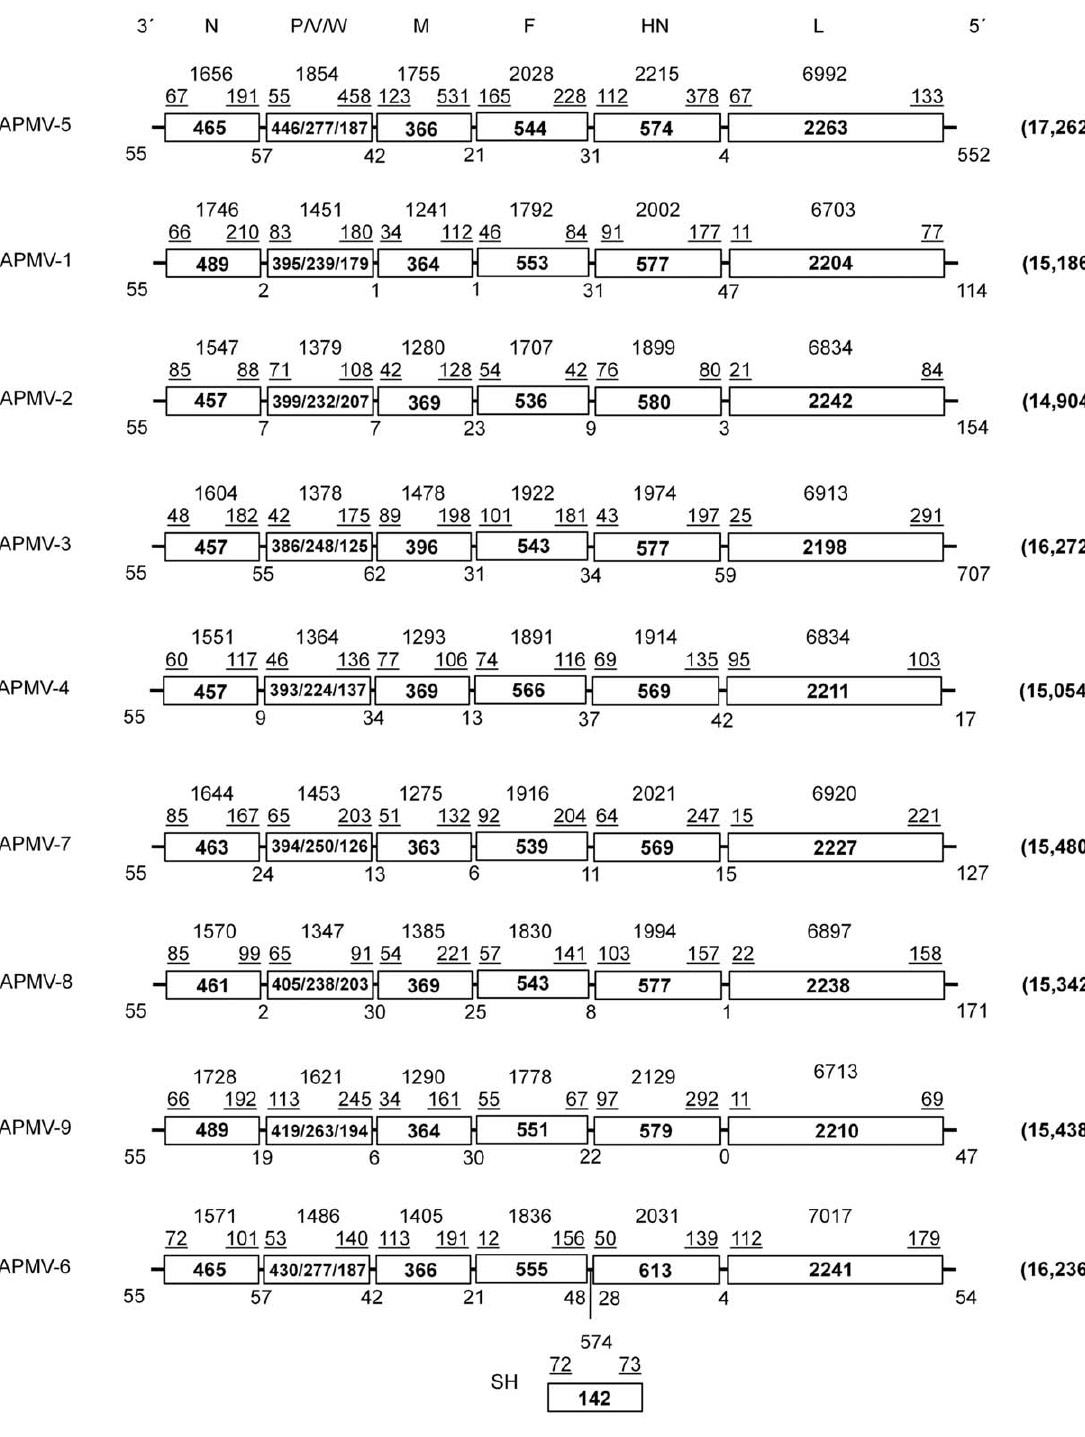
Figure 1. Gene map of APMV-5 and comparison with prototype strains for the other eight APMV serotypes (maps not to scale). Individual genes are indicated by rectangles, with the gene names given at the top of the Figure. The amino acid length(s) of the encoded protein(s) is shown in each box. The nt length of the gene is shown over each box. The lengths of the non-translated upstream and downstream regions (which also are represented in the total gene length) are indicated by underlined values immediately over each box. The nt lengths of the non-coding leader, intergenic, and trailer regions are shown under each map, and the total genome nt length is shown in parentheses to the right. The SH gene is present in APMV-6 but not in the other APMVs. Upstream UTRs include the GS sequence and the downstream UTRs include the GE sequence. The prototypes strains used here and in the other Figures and Tables are as follows: APMV-5, APMV-5/budgerigar/Kunitachi/74 (present study); APMV-1, Newcastle disease virus (strain LaSota/46); APMV-2, APMV-2/Chicken/California/Yucaipa/56; APMV-3, APMV-3/PKT/Netherland/449/75; APMV-4, APMV-4/duck/Hongkong/D3/75; APMV-6, APMV-6/duck/HongKong/18/199/77; APMV-7, APMV-7/dove/Tennessee/4/75; APMV-8, APMV-8/goose/ Delaware/1053/76; APMV-9, APMV-9/duck/New